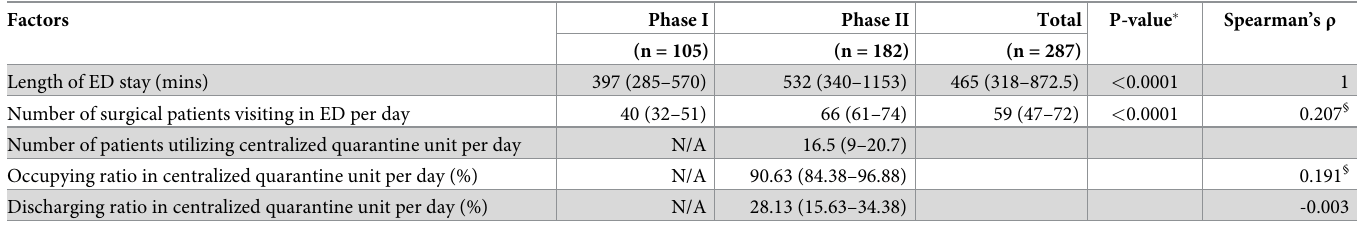
Table 2. Efficacy index of ED and the centralized quarantine unit.